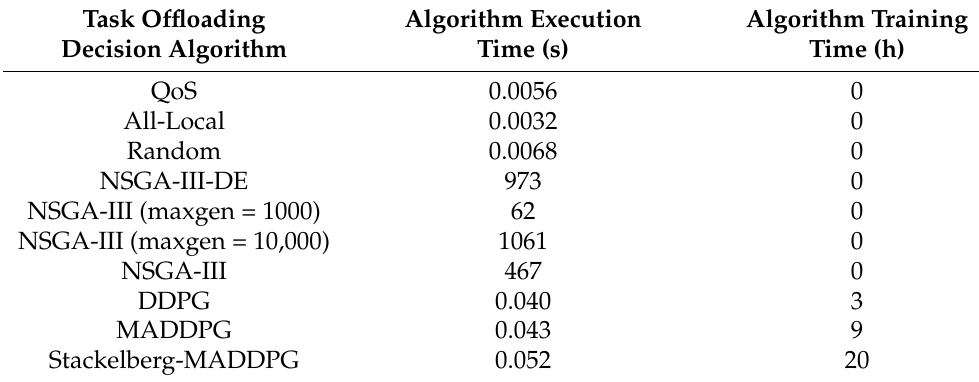
Table 2. Execution time and training time of different task offloading strategy